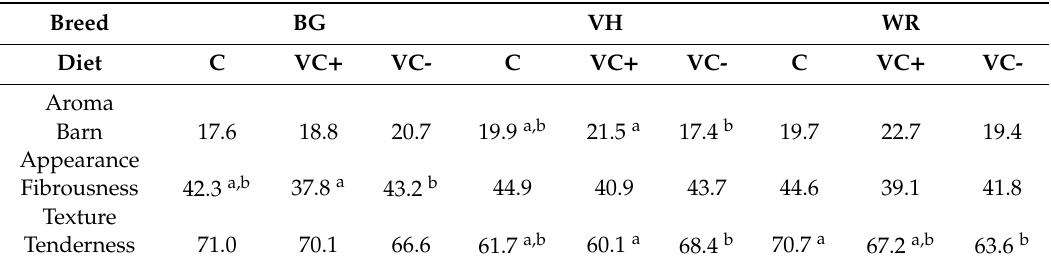
Table 4. Estimated marginal means of statistically significant ( α = 0.05) sensory attributes ( n = 10, r = 3), as quantified using unstructured line scales (0 = not perceptible, 100 = strongly perceptible), of chicken breast samples per breed (BG = Bresse Gauloise, VH = Vorwerkhuhn, WR = White Rock) and feed (C = control, VC + = high in vicin, VC- = low in